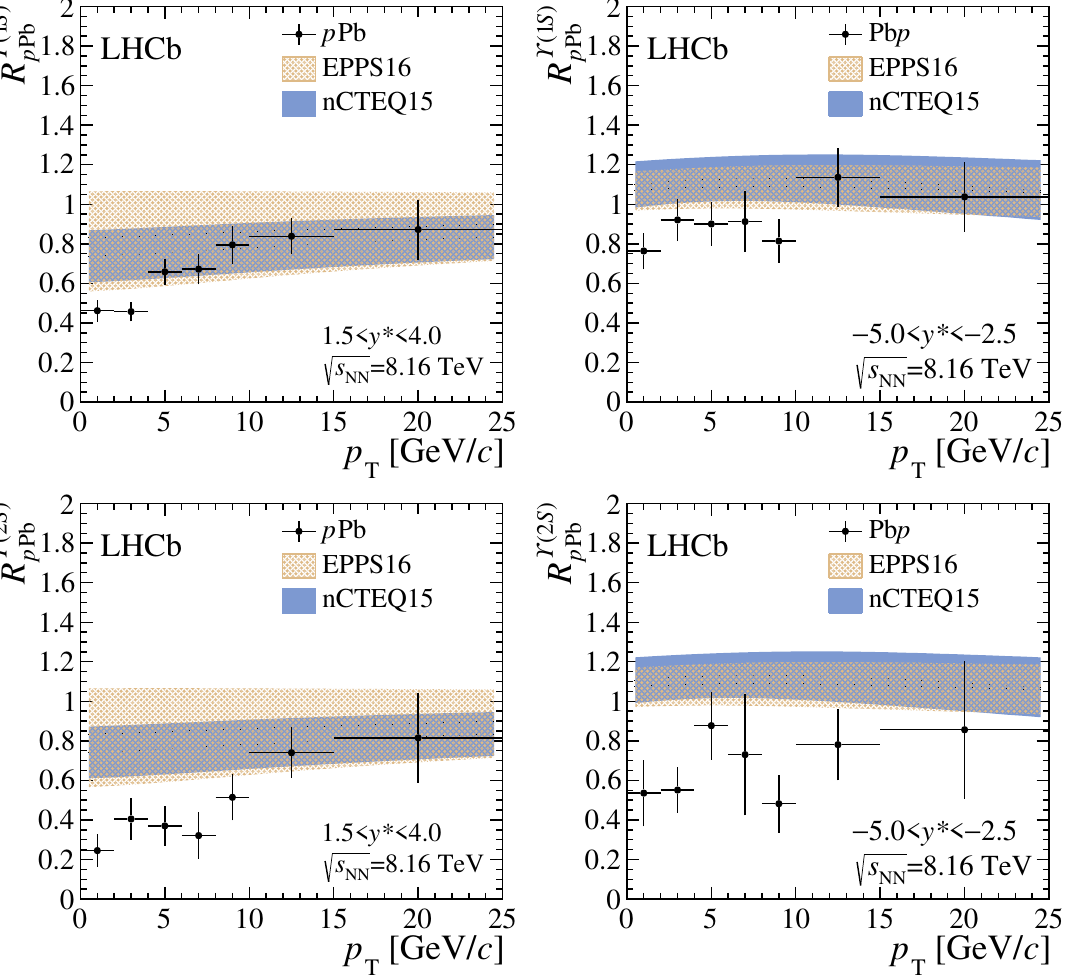
Figure 7 . Nuclear modi(cid:12)cation factors of the (top) (cid:7) (1 S ) and (bottom) (cid:7) (2 S ) mesons as a function of p T integrated over y (cid:3) for the (left) forward and (right) backward samples. The bands correspond to the theoretical predictions for the nCTEQ15 and EPPS16 nPDFs sets as reported in the